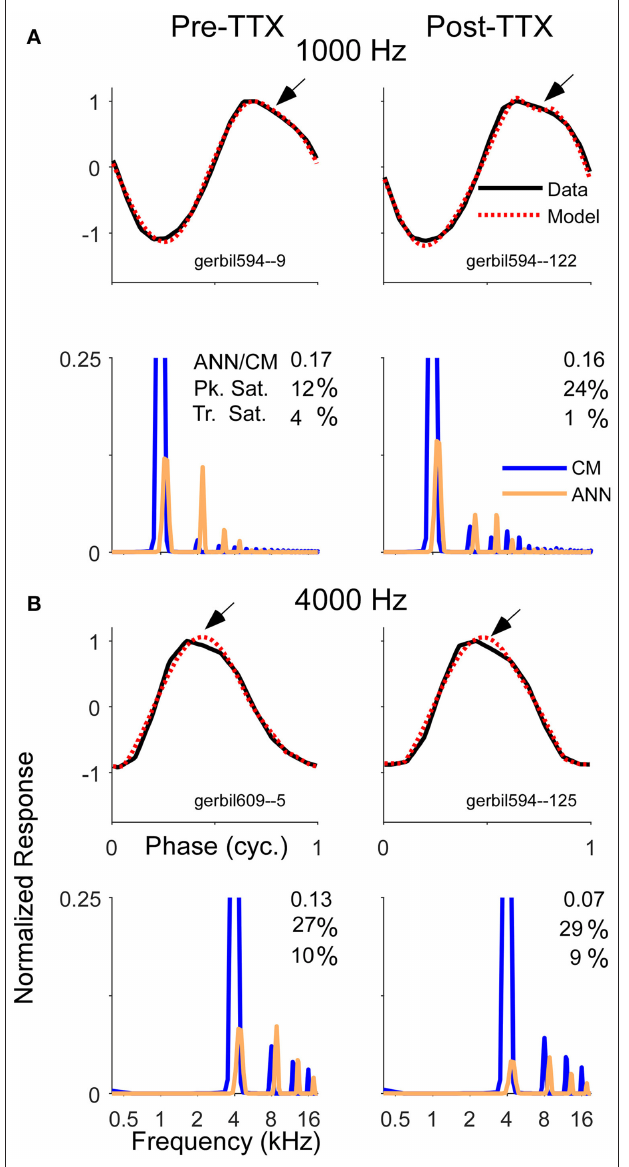
FIGURE 10 | Examples of average cycle waveforms and frequency spectra in response to tone bursts at 80 dB SPL. These examples depict a particular type of ECochG response that does not conform to the shapes expected for CM. To the 1,000Hz (A) and 4,000Hz stimuli (B) there was a sloping response to the clipped peak of the average cycle (arrows). To a 1,000Hz stimulus at this sound level the ANN should be a relatively small proportion of the response, and smaller still after TTX. For the 4,000Hz stimulus there should be little or no ANN either before or after TTX. Thus, these waveforms are likely to be nearly-pure CM. The model did capture considerable clipping of the CM, indicated by the large saturation values reported for the peak (Pk. Sat.) and smaller values for the trough (Tr. Sat.). However, the spectrum of each modeled waveform showed considerable ANN even after TTX, suggesting the model interpreted the sloping shape of the CM as ANN. The waveforms and the spectra are normalized to the amplitude of CM contribution measured by the model. The CM of the first harmonic is off-scale to emphasize the higher harmonics, which were present due to the clipping. The spectrum of the ANN is slightly displaced for